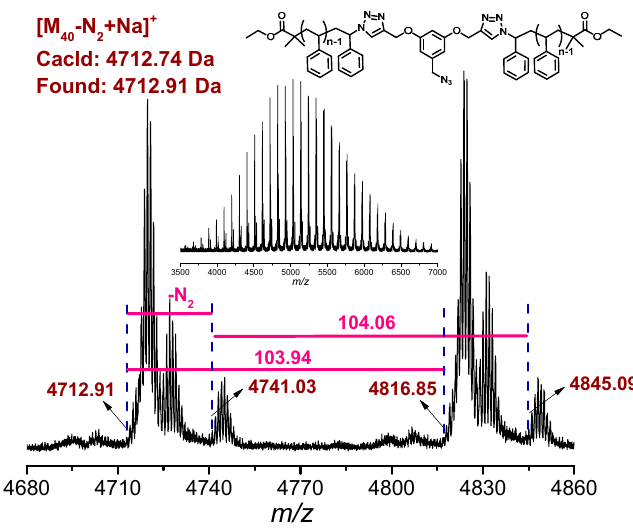
Figure 7. Expanded MALDI-TOF MS of l -PS-PhN 3 with inserted full spectrum.